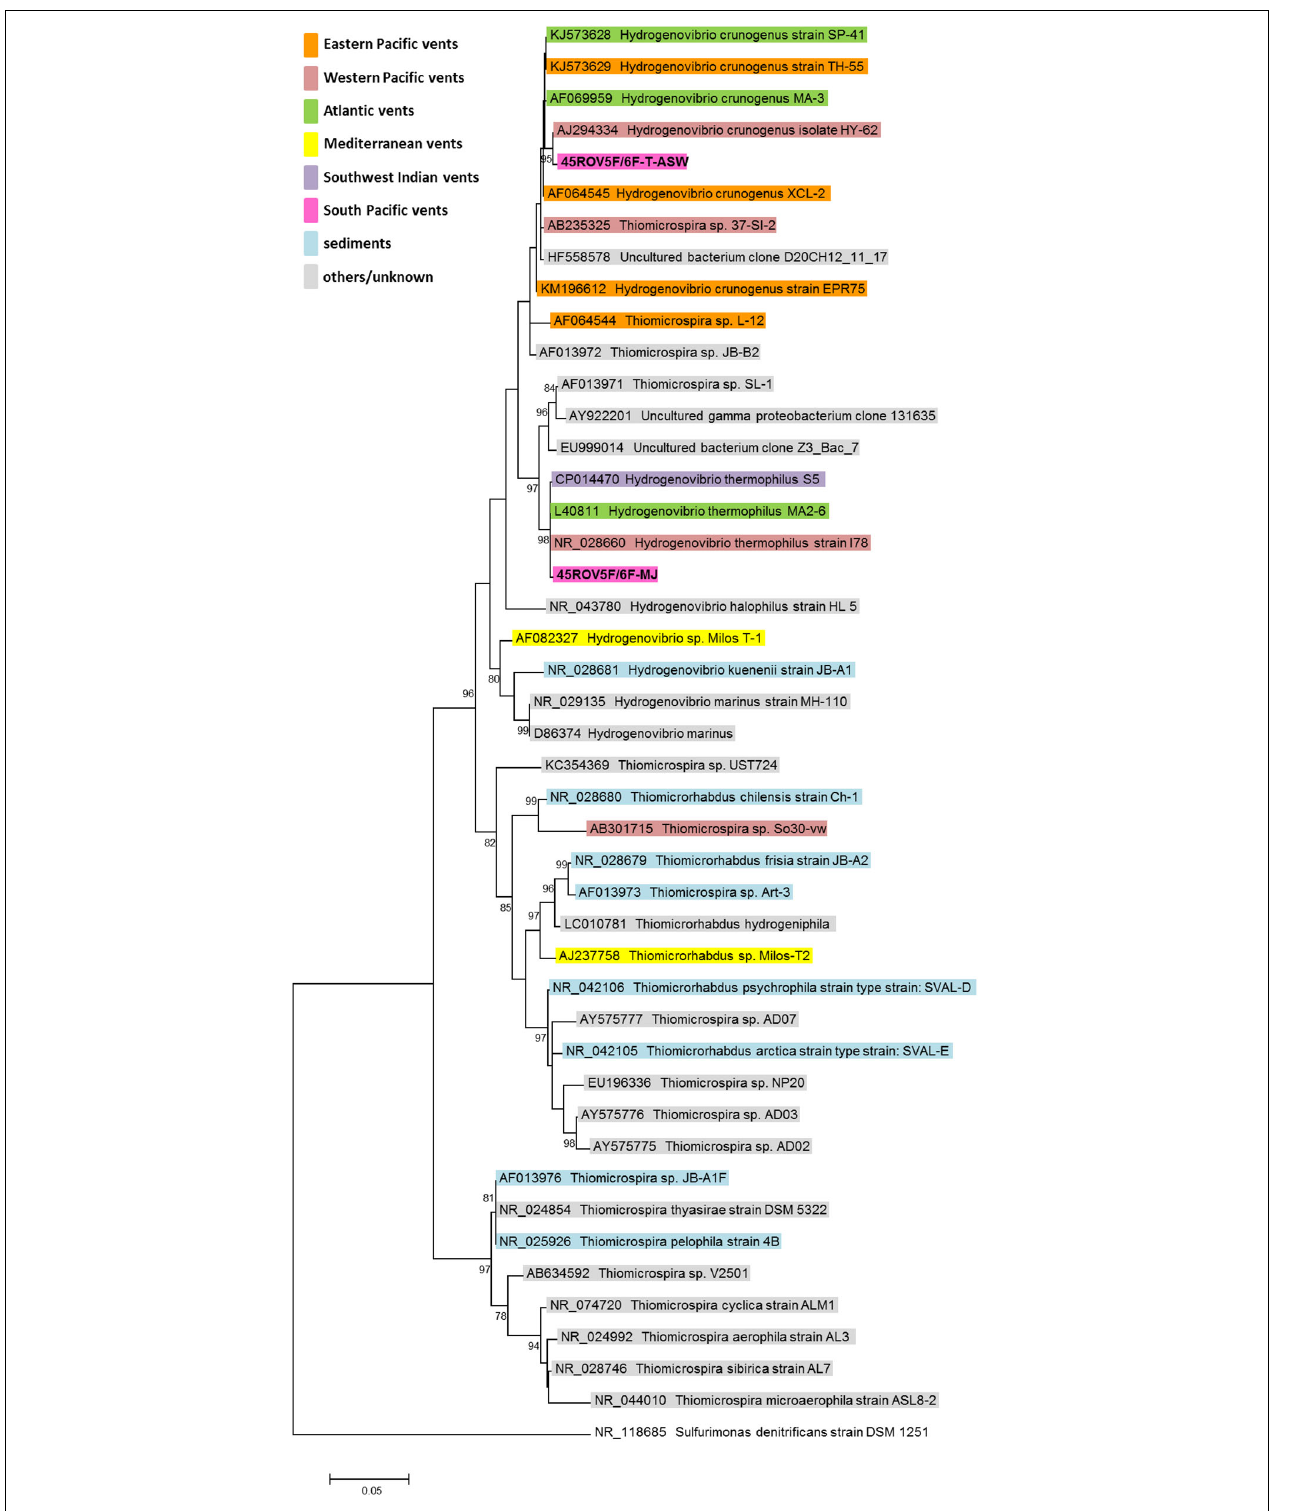
FIGURE 1 | Phylogenetic relationship of Thiomicrospira and Hydrogenovibrio species based on 16S rRNA genes. Sequences were aligned using the multiple sequence alignment web server T-Coffee (Notredame et al., 2000) with followed construction of the phylogenetic tree using Mega-X (Kumar et al., 2018) and 1000 bootstraps. The Thiomicrospira and Hydrogenovibrio species are color-coded according to their isolation source. The strains described here are written in bold. The scale bar represents the changes per nucleotide. Only bootstrap values higher than 75 are given.